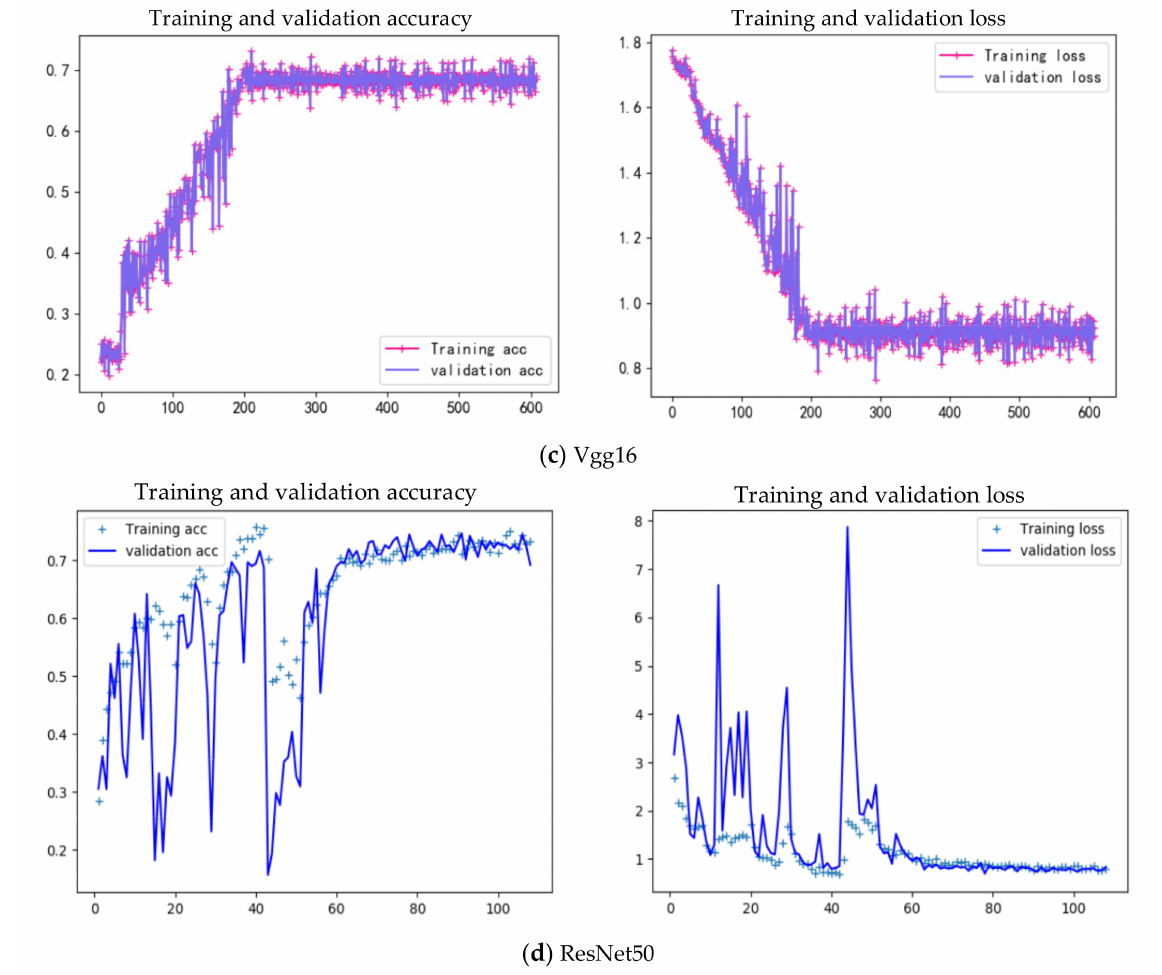
Figure 6. The training and verification results of the proposed method. ( a ) MLH-CNN training and validation curve, ( b ) AlexNet training and validation curve, ( c ) Vgg16 training and validation curve, ( d ) ResNet50 training and validation curve.